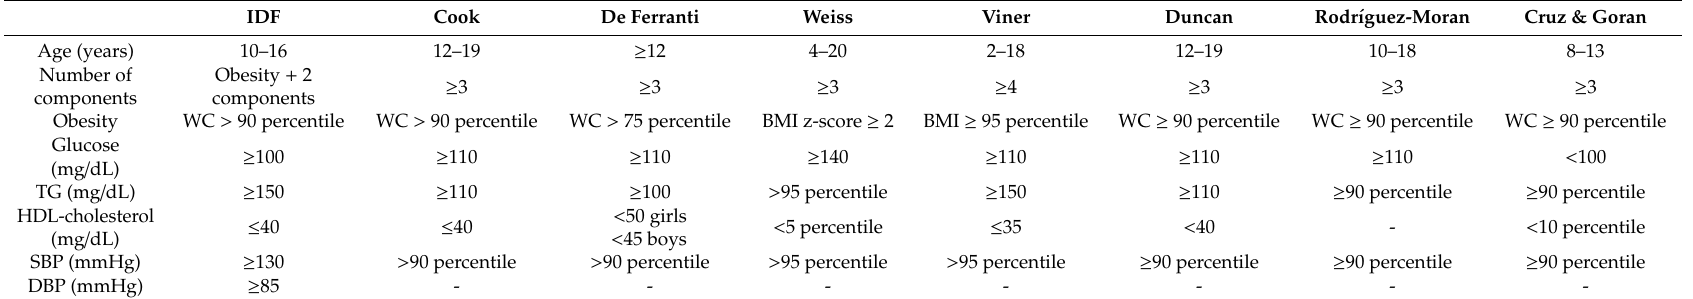
Table 1. Diagnostic criteria for the MetS in